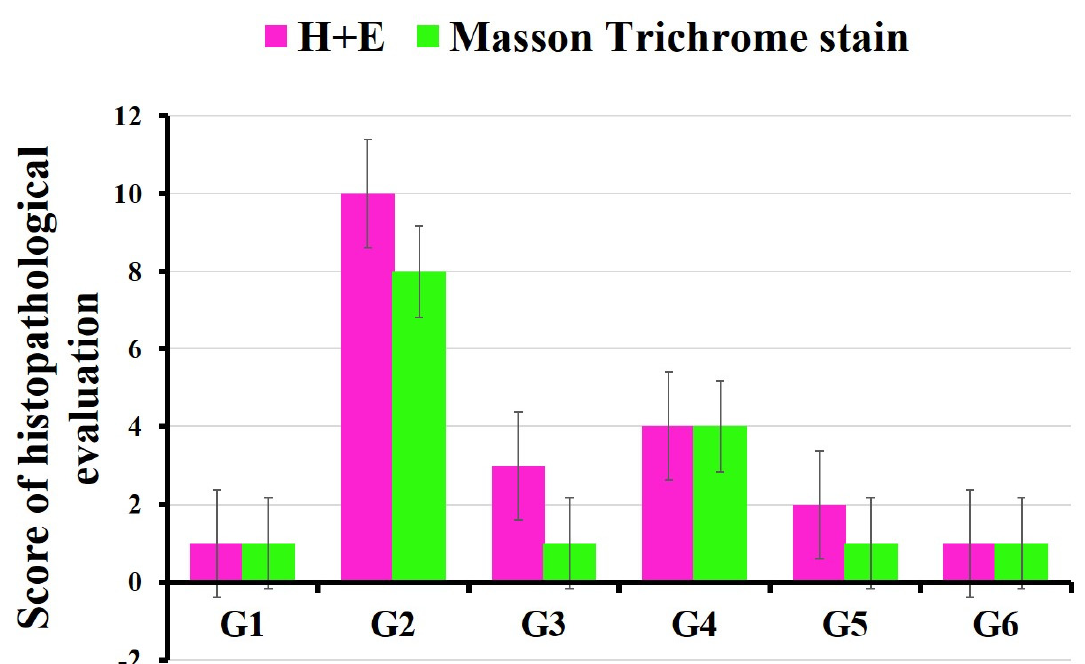
Figure 13. Scores of histopathological evaluation of different animal groups. G1: control. G2: BPA. G3: MOLE. G4: MOLE ‐ BPA. G5: Encap. MOLE. G6: Encap. MOLE ‐ BPA.